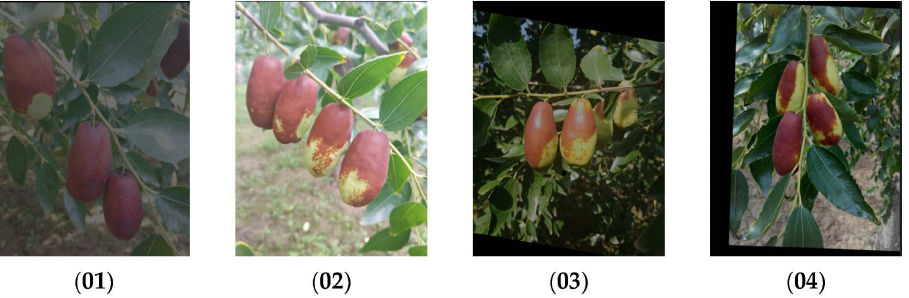
Figure 2. Images of Lingwu long jujubes after the data augmentation: ( 01 ) Add noise; ( 02 ) Boost brightness; ( 03 ) Decrease brightness; ( 04 ) Random